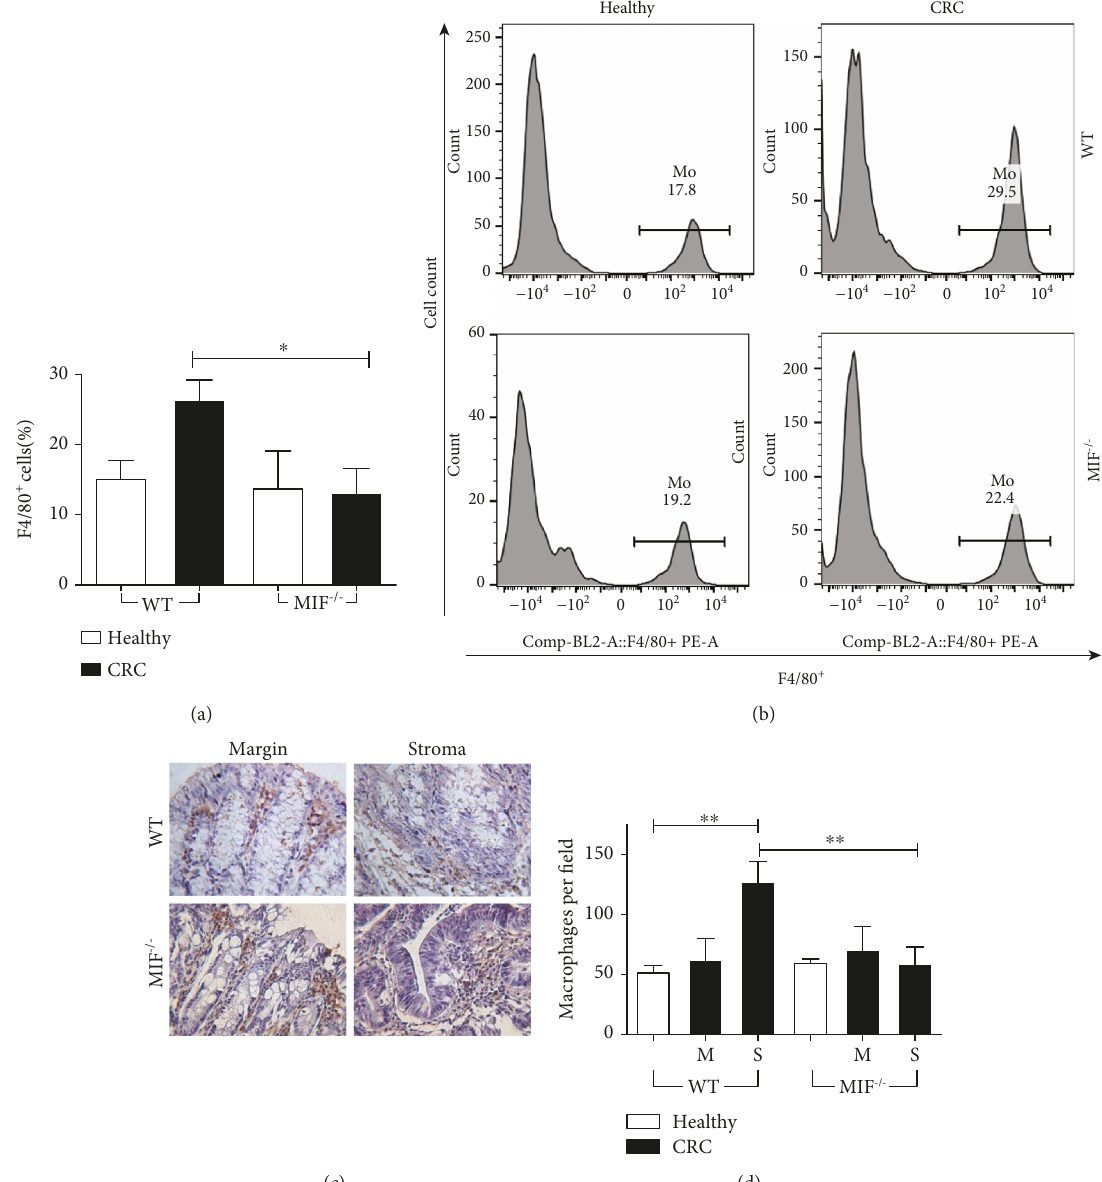
Figure 5: The macrophage population in the tumor stroma is diminished in the absence of MIF. (a) F4/80 + CD11b+ macrophage percentage and (b) representative histograms of macrophage staining in the lamina propria from the colon of a mouse with colorectal cancer. (c) Immunohistochemical analysis of macrophages (F4/80 + cells) and (d) quanti fi cation of the number of macrophages in the tumor margin (M) and tumor stroma (S). Data are representative of three independent experiments and are plotted as the means ( ± SEM), n = 3 mice per group; ∗ p < 0 05 , ∗∗ p < 0 01 , and ∗∗∗ p < 0 001 (Figure 7(c)) compared to β -actin expression by endpoint RT-PCR. Representative electrophoresis gels are observed in Figure 7(d). No statistical di ff erences were found in the expressions of these genes. Also, foxp3 and il-17 (Figure 7(e)) were analyzed by real-time PCR; we observed an increase in the transcription of the il-17 gene in MIF -/- CRC samples ( 22 86 ± 1 744 ‐ fold change ) compared to WT CRC samples ( 6 226 ± 1 634 ‐ fold change ). No di ff erences were found in tnf- α , il-10 , and tfg- β (Supplementary Figure 1).